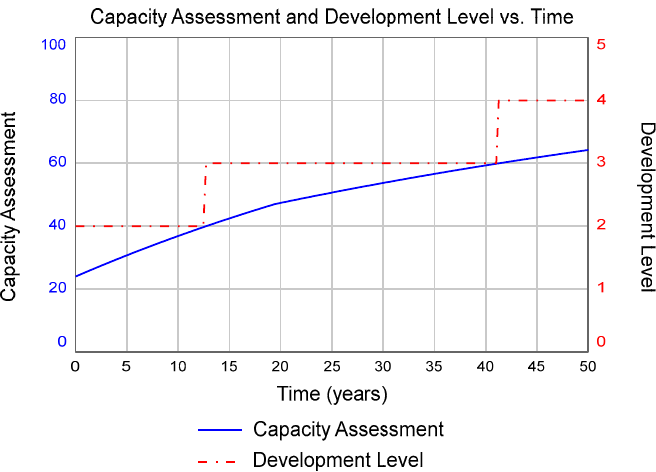
Figure 6. Variation of community capacity assessment and community capacity (development) level with time assuming capacity dependency and an enabling environment.